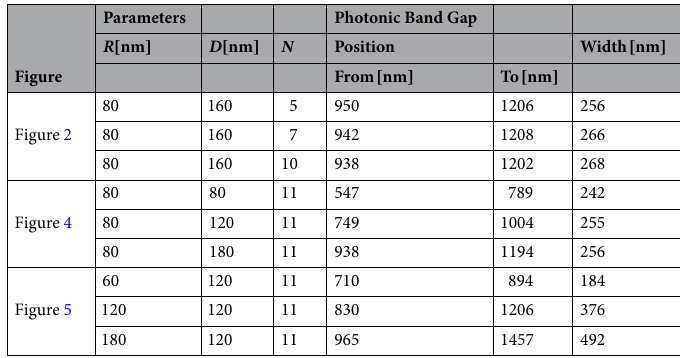
Table 1. The parameters of each figure with the width and position of the PBG.